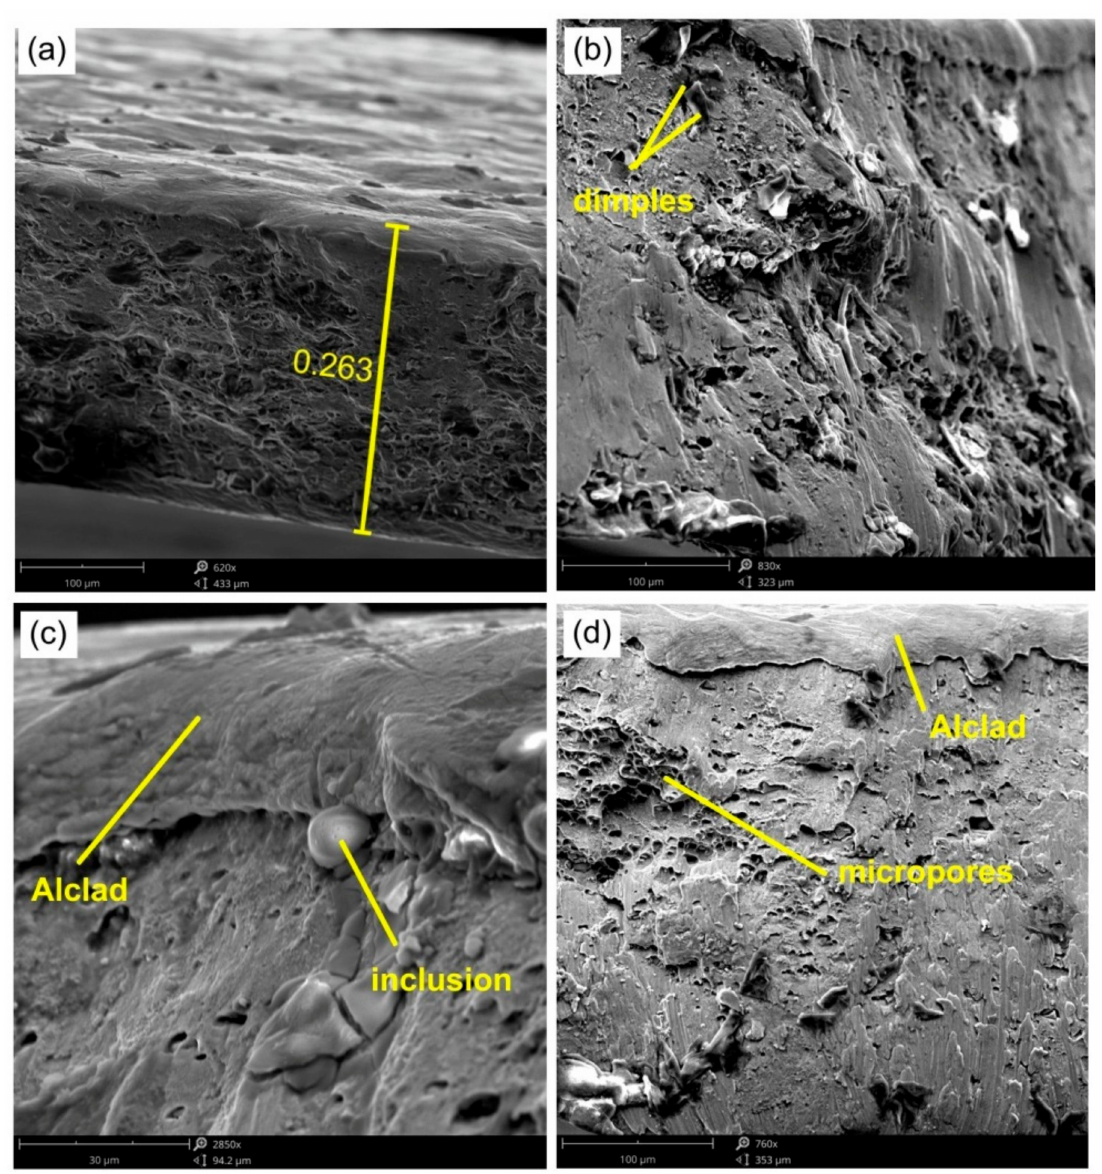
Figure 17. SEM micrographs of the fracture surface of a panel made of 0.5-mm-thick EN AW-2024-T3 Alclad sheet: Micrographs ( a – d ) show various fragments of the ductile